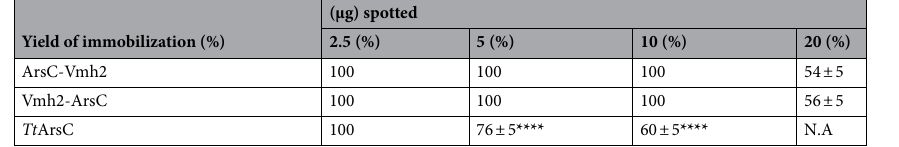
Table 1. Yield of immobilization of ArsC-Vmh2 and Vmh2-ArsC compared to Tt ArsC on polystyrene plates. N.A. not analysed. Statistical analysis was performed through the ordinary one-way ANOVA on GraphPad Prism 7.00; significant differences of TtArsC in comparison to chimeras are indicated as: * p < 0.05; ** p < 0.01; *** p < 0.001; **** p < 0.0001. The variability is reported as standard deviation.